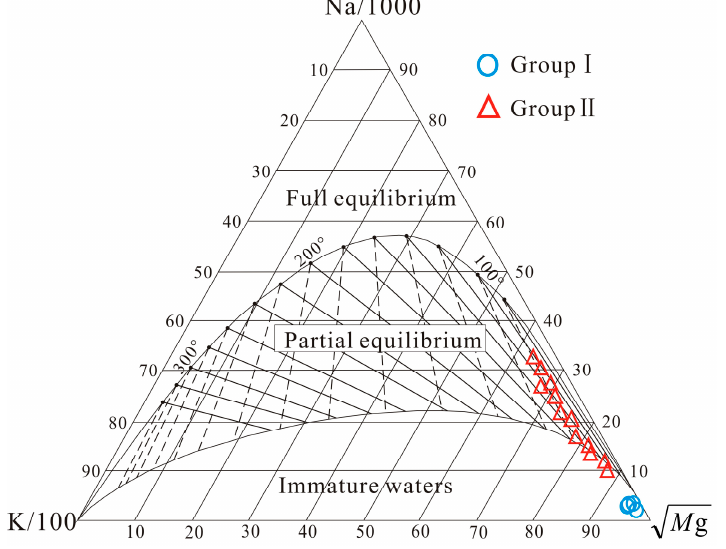
Figure 7. Triangular diagram of Na–K–Mg 1/2 .